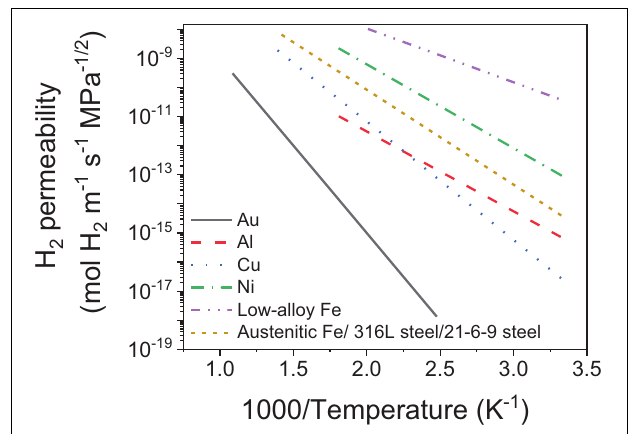
FIGURE 11 | Hydrogen permeability of various alloys and metals as a function of temperature. Austenitic Fe is an average of austenitic stainless steels such as 316L steel and 21-6-9 steel (Louthan and Derrick, 1975; Xiukui et al., 1989); low-alloy Fe is 4130 quenched and tempered (Nelson and Stein, 1973) and pure metals i.e., Au (Begeal, 1978), Al (Song et al., 1997), Cu (Begeal, 1978), and Ni (Louthan et al., 1975). [Reproduced from Walker (2008)].